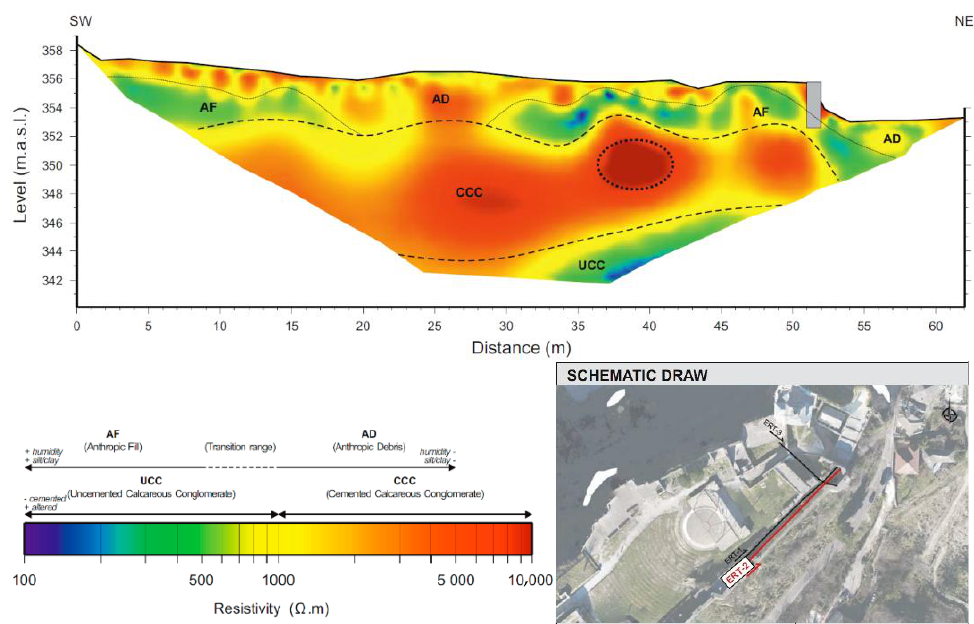
Figure 9. Geoelectrical model obtained for ERT-2. The presence of a geoelectrical anomaly that corresponds to a cavity under the wall located next to the tower is clearly observed. (Photo credit of schematic draw: GEA, based on photo by Rand Eppich)